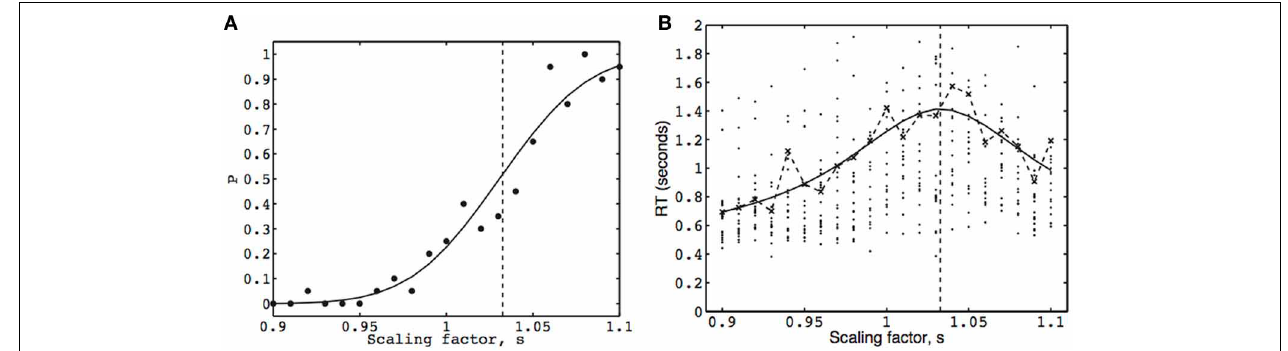
Figure 4A (RTs greater than 2s are not shown). The fitted chronometric function is defined in Equation 8. The dashed curve joins the fitted (inverse Gaussian) mean RTs, each of which was obtained by maximizing Equation 17. The solid curves in (A, B) (Equations 6, 8, respectively) were fitted using combined binary and mean RT data by maximizing Equation 22. A graph similar to (A) was obtained for model L P (i.e., using only binary responses), and a graph similar to (B) was obtained for model L ¯ τ (i.e., using only mean RTs).